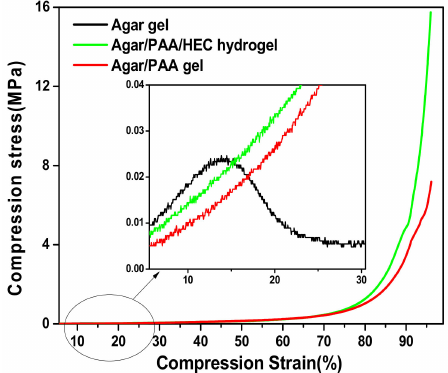
Figure 4. Agar / PAA / HEC hydrogels show extraordinary mechanical: ( a ) Bending; ( b ) Knotting; ( c ) Compression; ( d ) Elongation.